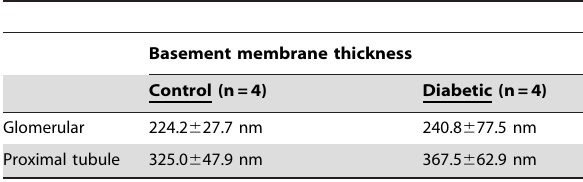
Table 3. GBM and proximal tubule basement membrane thickness at 30 weeks of age.